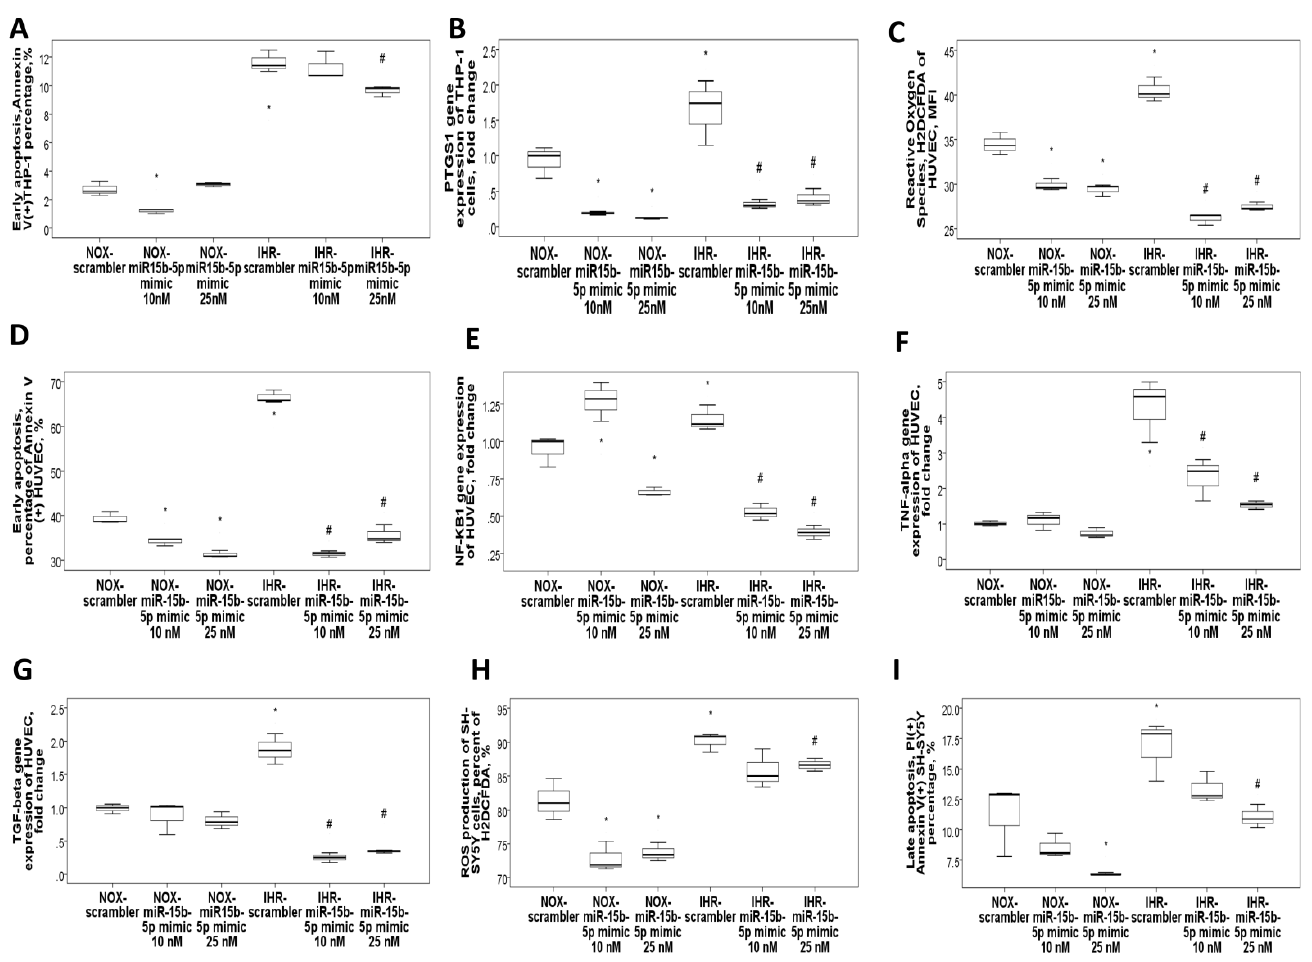
Figure 6. MiR-15b-5p over-expression reversed intermittent hypoxia with re-oxygenation (IHR)-induced apoptosis, oxidative stress, and up-regulation of its target genes. Transfection with a miR-15b-5p mimic in THP-1 cells reversed IHR-induced ( A ) early apoptosis and reversed IHR-induced up-regulation of its predicted target mRNA, ( B ) PTGS1 . Transfection with miR-15b-5p in HUVEC reversed IHR-induced ( C ) reactive oxygen species production, ( D ) early apoptosis, and up-regulation of its predicted target genes, including ( E ) NF- κB1 , ( F ) TNF- α , and ( G ) TGF- β . Transfection with a miR-15b- 5p mimic in SH-SY5Y cells reversed IHR-induced ( H ) ROS production and ( I ) late apoptosis. * p < 0.05, compared with normoxic (NOX) condition. # p < 0.05, compared with IHR condition.